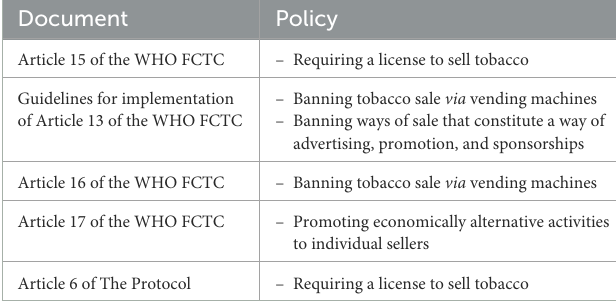
TABLE 1 Policies identified in the WHO FCTC and related documents.